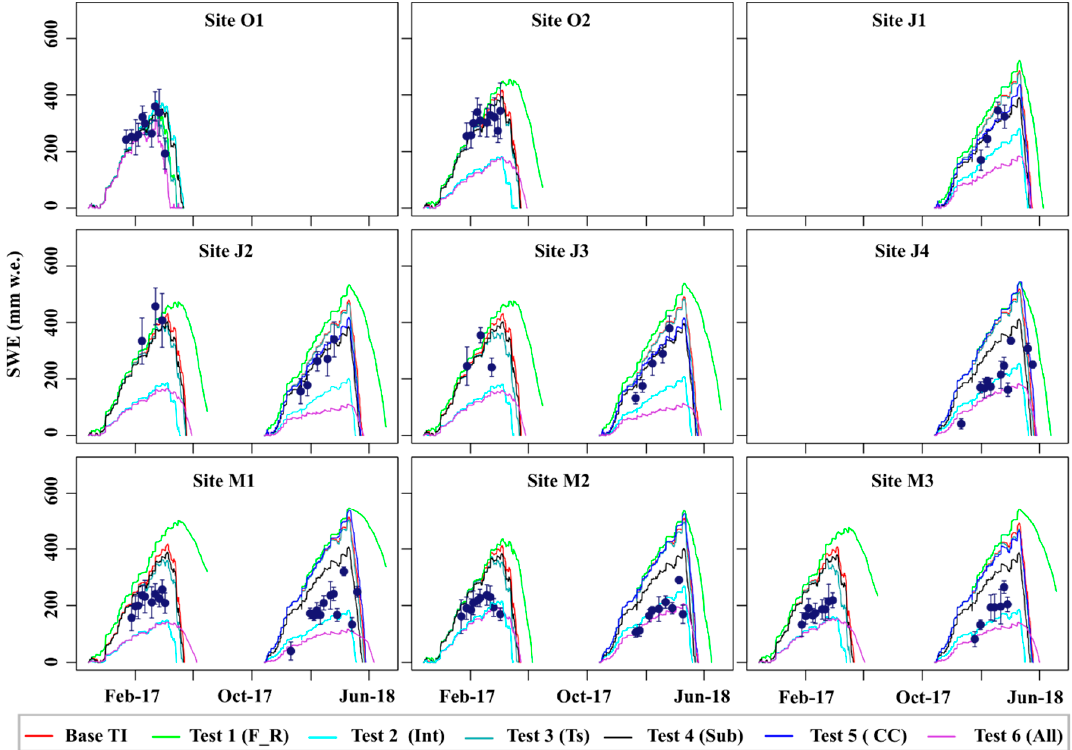
Figure 7. Hourly observed and simulated SWE for tests 1 to 6, using A1 as the base model. F_R indicates for forest and radiation, Int is snow interception, Ts is snow surface temperature, Sub is sublimation, and CC is cold content. The necessary inputs (snow depth and Ts) for test 5 were available for W2 only, limiting our test. Points illustrate the average SWE and the error bars denotes the standard deviation.